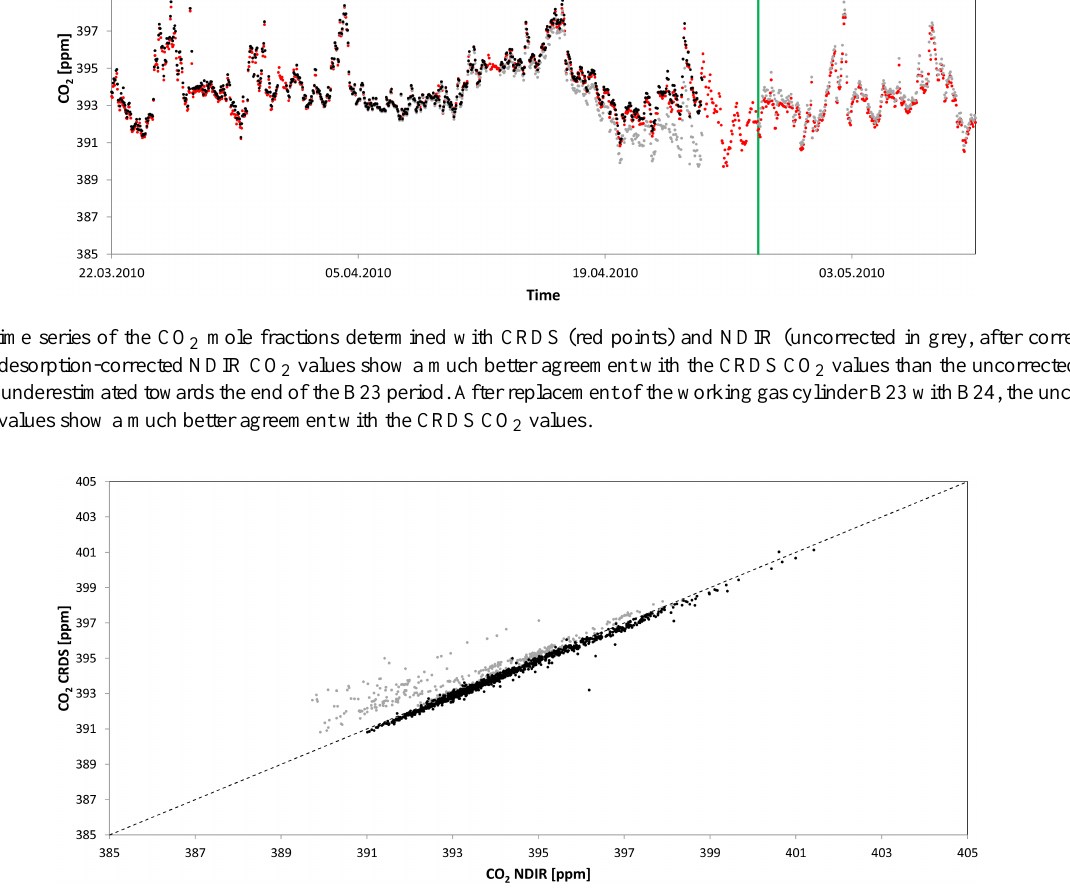
Figure 8. Correlation of ambient CO 2 mole fraction measured by CRDS versus the uncorrected CO 2 mole fraction of the NDIR instrument (grey points) and the desorption-corrected CO 2 NDIR mole fractions (black points), respectively during the period of the working gas cylinder B23. The diagonal represents the ideal 1 : 1 agreement. Due to the CO 2 enrichment in the working gas cylinder B23 the uncorrected KUP values seem to be much lower than the Empa values. By applying the correction, the values of the two systems are in a much better